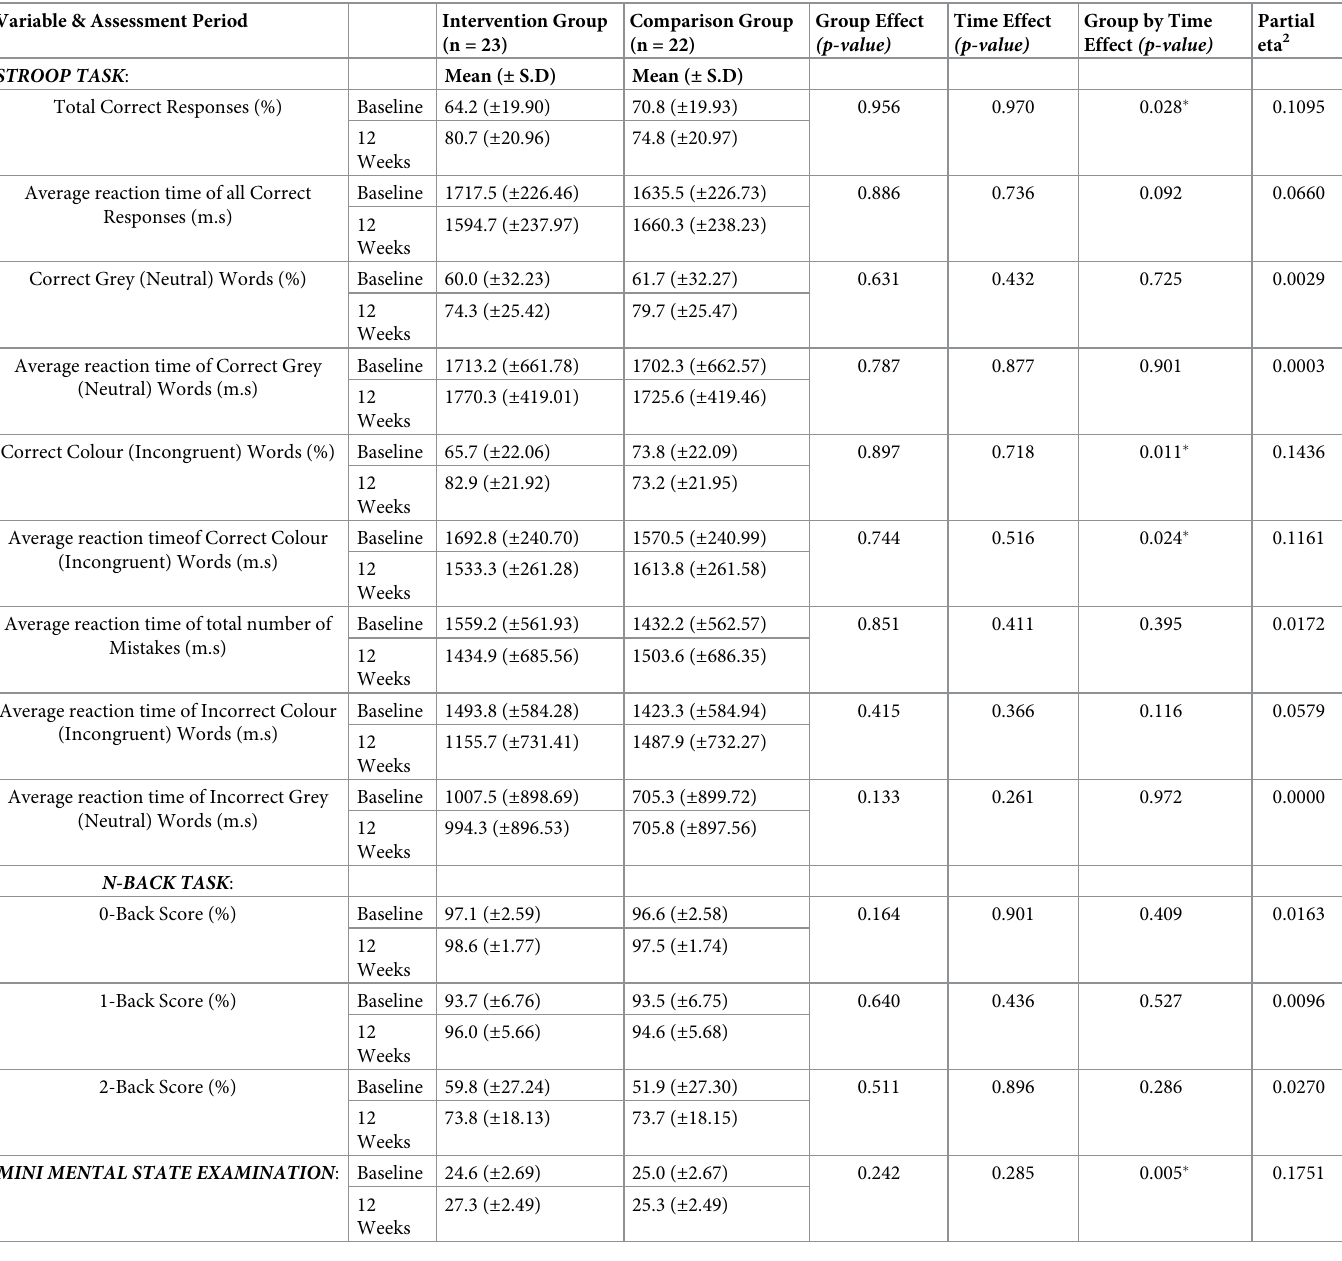
Table 6. Changes in cognitive performance in the intervention and comparison